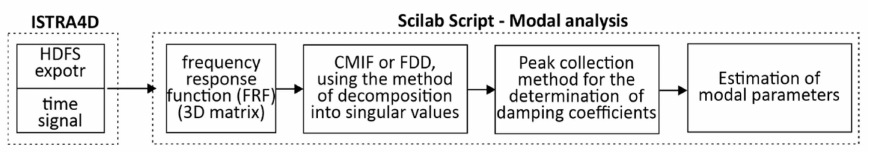
Figure 6. Procedure for processing measured and exported data.